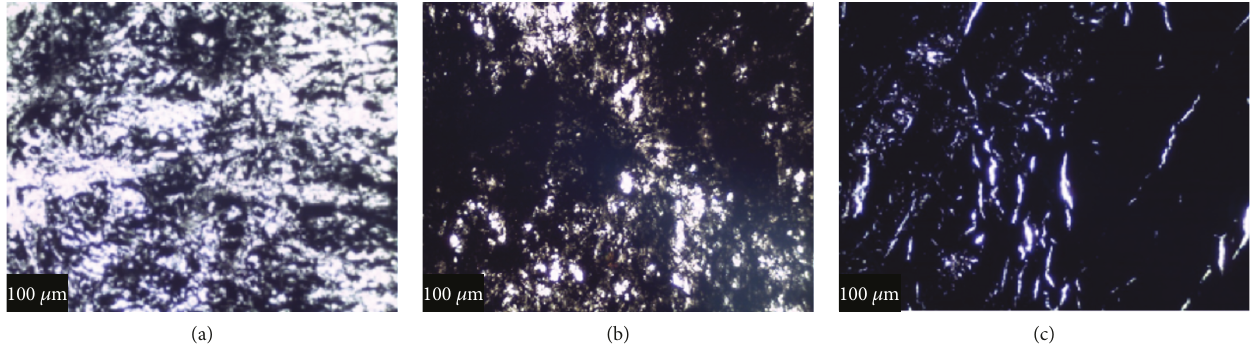
Figure 10: OM image of di ff erent ink ((a) commercial 1; (b) commercial 2; (c) CGCe ink).